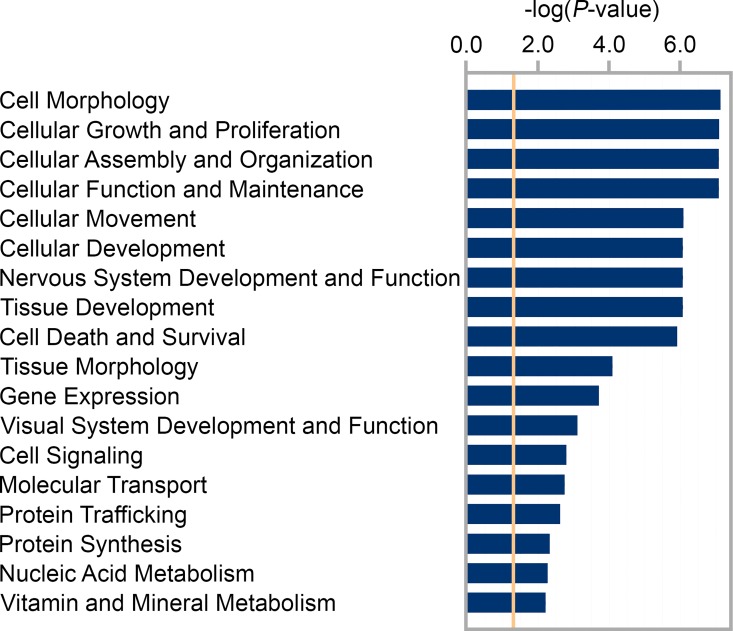
Gene ontology categories affected in myopic retina.Graph shows top 18 biological processes which were modified in the myopic retina.